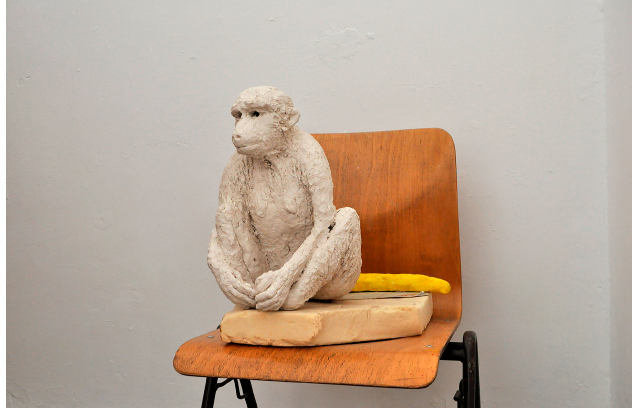
Figure 6. Monkey Business (2018), FILET, London. Ceramic, 50 × 36 × 25 cm. “She wonders if she can look the pig in the eye. The neighbour has a heart valve from a pig. The pig’s eye is very similar to the human eye, and so is the heart. The pig is afraid when it is killed. It feels the danger and screams.” (Jurack 2022) Brown eyes, pale blue eyes, orange eyes, green eyes, black eyes. Can you look into the pale blue eyes of a pig? Her eyes are so like our human eyes. Look into her eyes. Who do you see? The black eyes of a cow show the reflection of your gaze. The blue eyes of a pig, framed by pale eyelashes, look at us. I do not know if I could kill a pig after I looked her in the eyes, since she returned my gaze. I do not know if we recognized each other in that moment as equal entities. In what way did we recognize each other? Did we? I looked into your eyes, and I saw you looking at me looking at